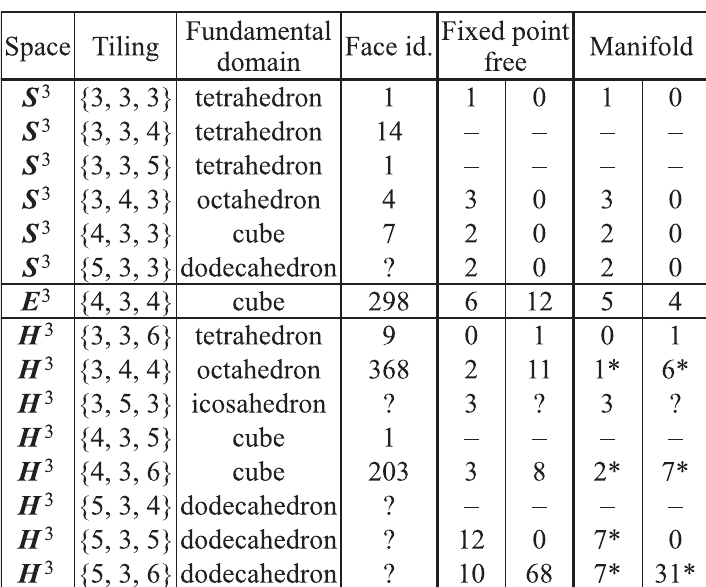
Table 2. Face id: the number of face identifications generating space groups. Fixed point free: the number of face identifications generating orientation preserving and orientation reversing fixed point free groups. Manifold: the number of determined orientable and non-orientable manifolds (star (*) means that the number is only a proved lower